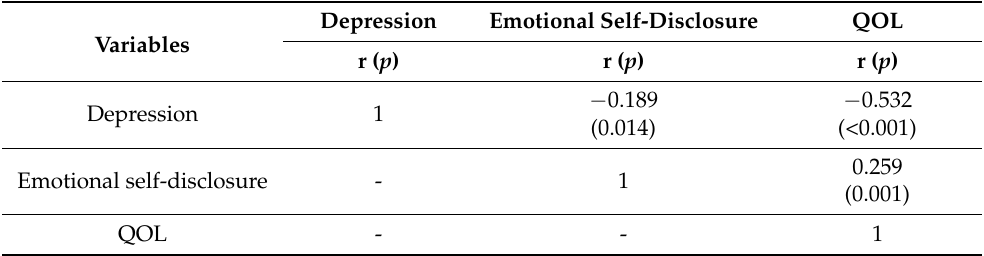
Table 3. Correlation between depression, emotional self-disclosure, and QOL ( n = 169).